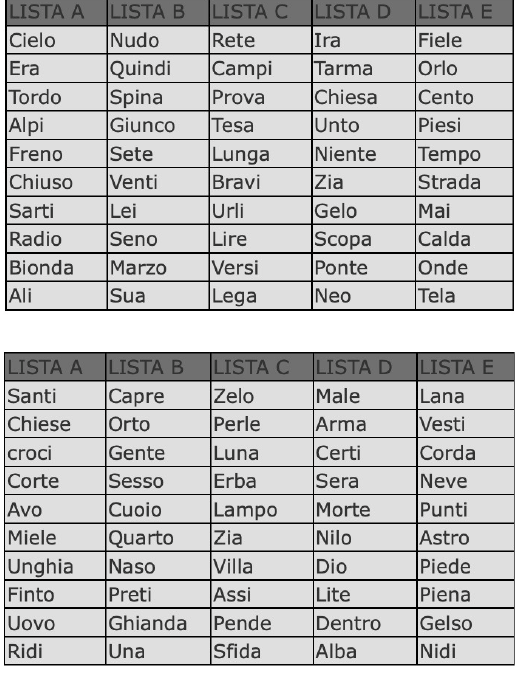
Figure 1. List of Italian words used to perform the speech perception test.